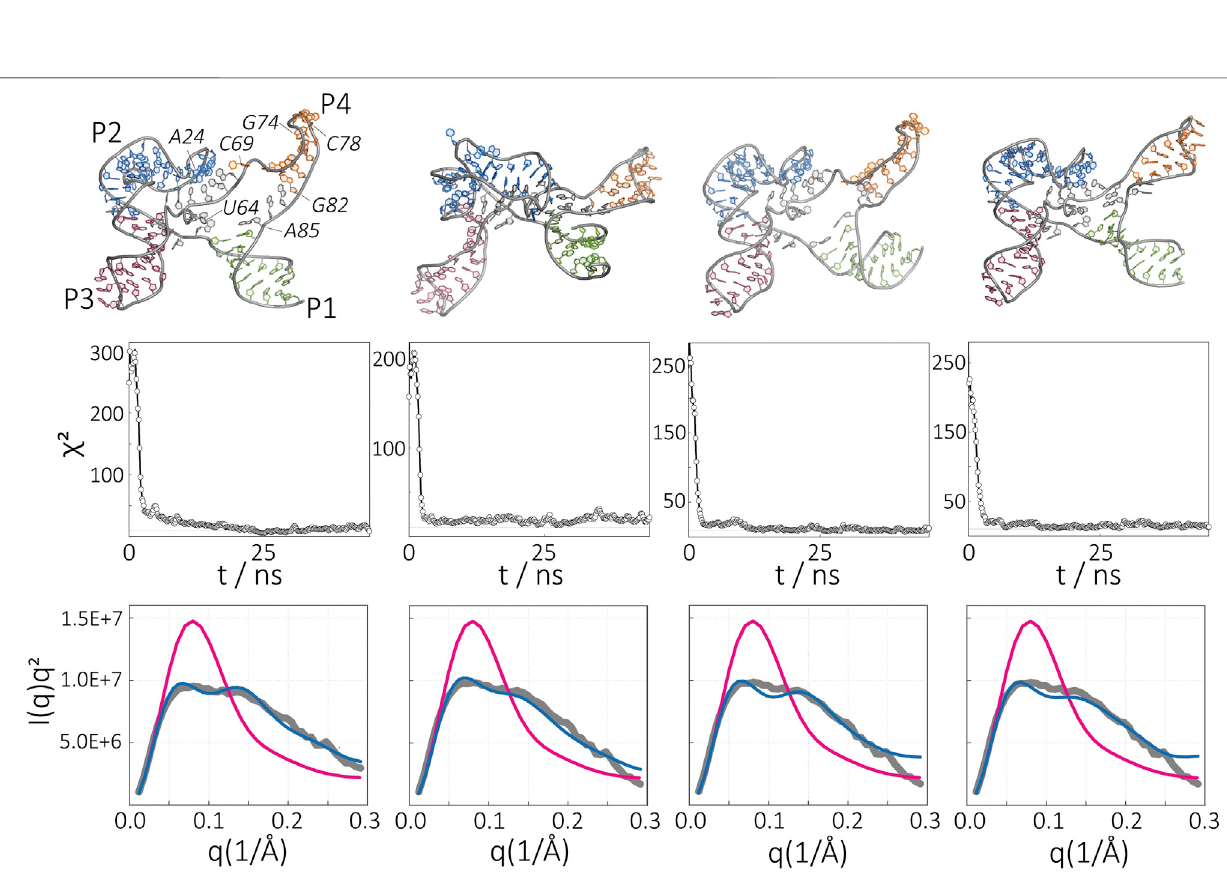
Frontiers in Bioinformatics |